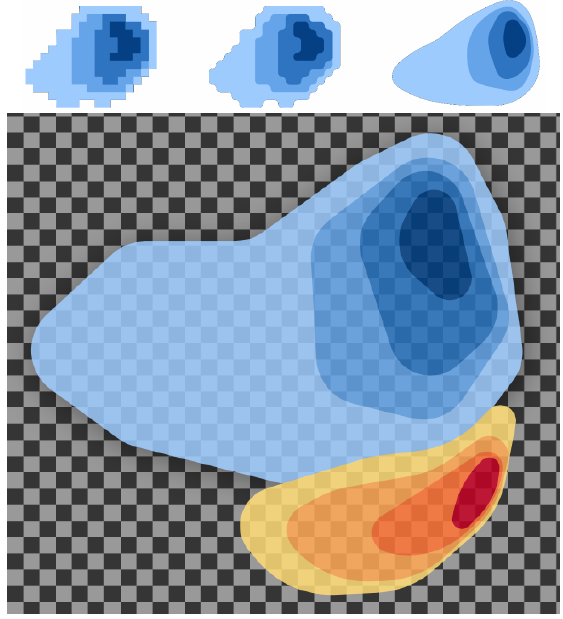
Figure 5. Top: cloud shapes for navigation systems: pixelated (left), rounded (middle) and smoothed (right). Bottom: example of rain cloud (blue) and snow (yellow red) shapes with 85% alpha transparency.